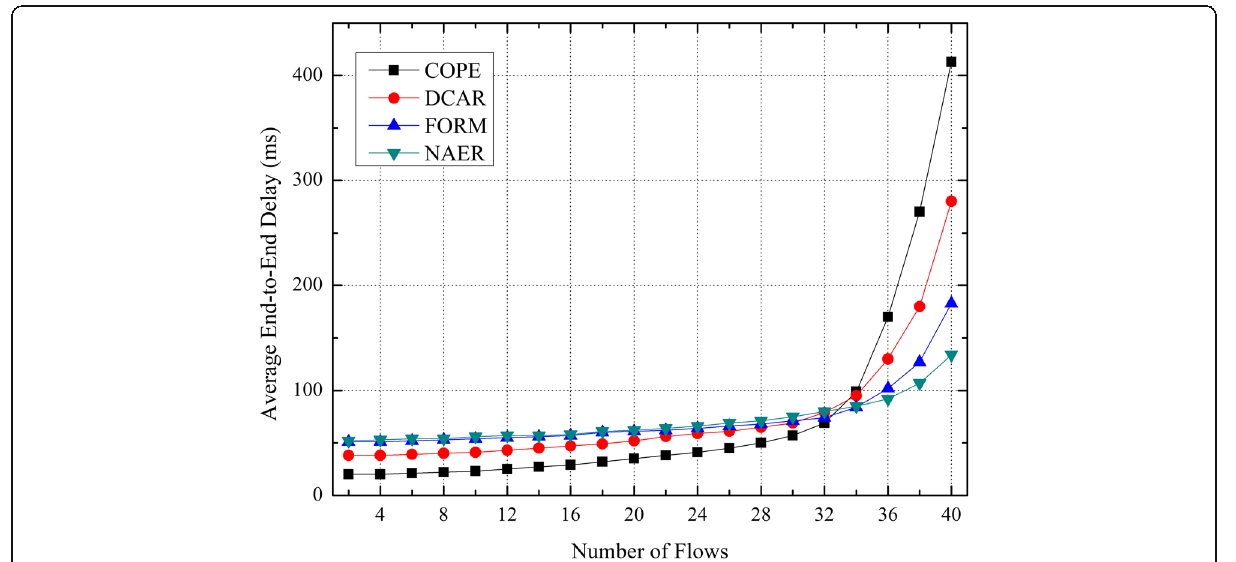
Fig. 26 Average end-to-end delay under different number of flows in random network. Figure 26 shows the average end-to-end delay comparison of COPE, DCAR, FORM, and NAER under different number of flows in random